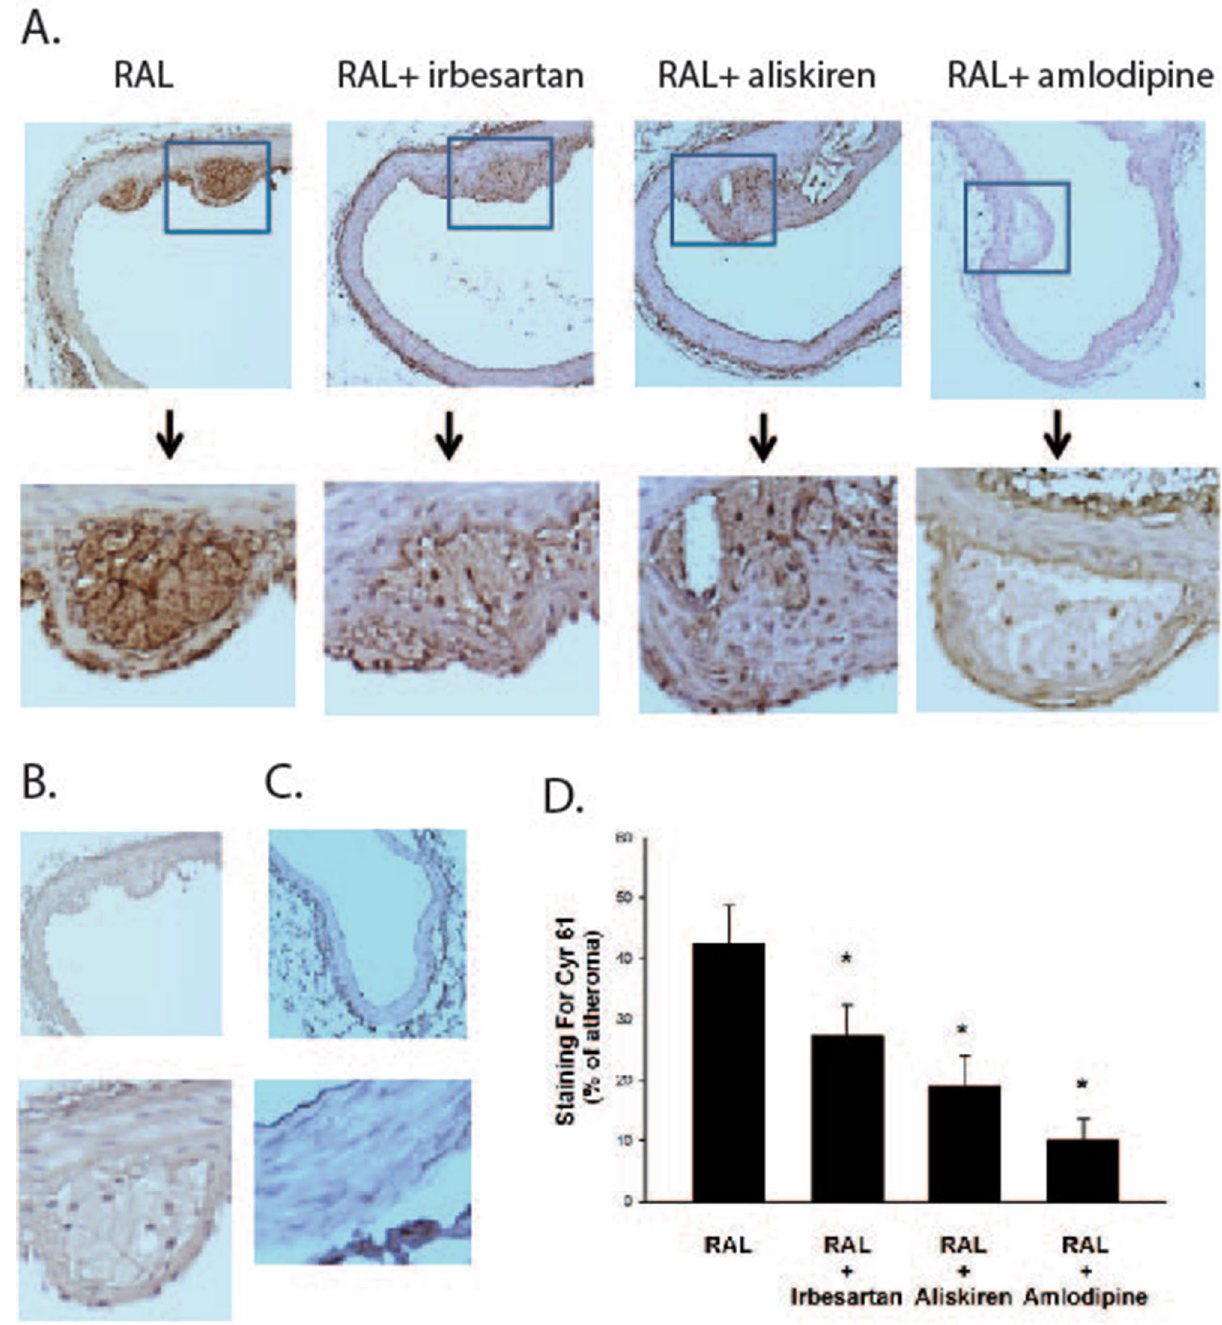
Figure 2. Cyr61 expression in aortic atheromas from ApoE −/− mice with unilateral renal artery ligation. Representative sections from the distal one-third of the descending aorta of ApoE −/− mice from various groups stained with anti-Cyr61 antibody ( A ) or no primary antibody (as a control, B ). A representative aortic section from a mouse that underwent sham-surgery stained with anti-Cyr61 antibody in shown in panel ( C ). There were no atheroma in mice that underwent sham-surgery. The area of atheroma that stained for Cyr61 is quantified in panel D [* p < 0.05 vs RAL